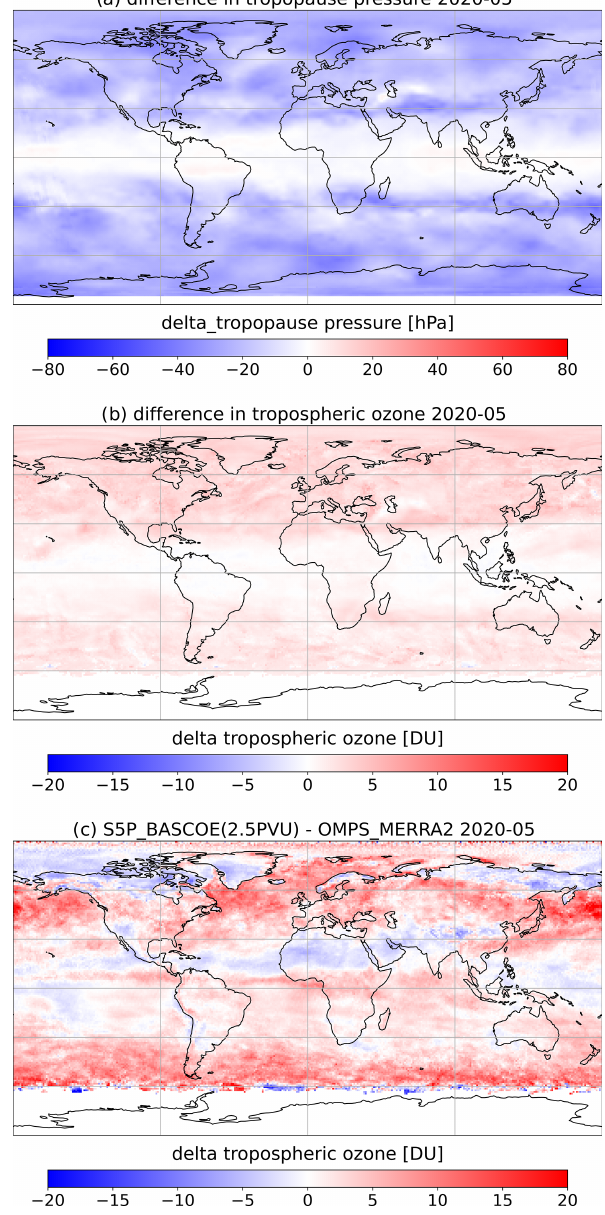
Figure 6. Monthly mean tropospheric ozone columns for May 2020 as observed by S5P-BASCOE (a) , OMPS-MERRA-2 (c) , and the difference between these two datasets (b) .